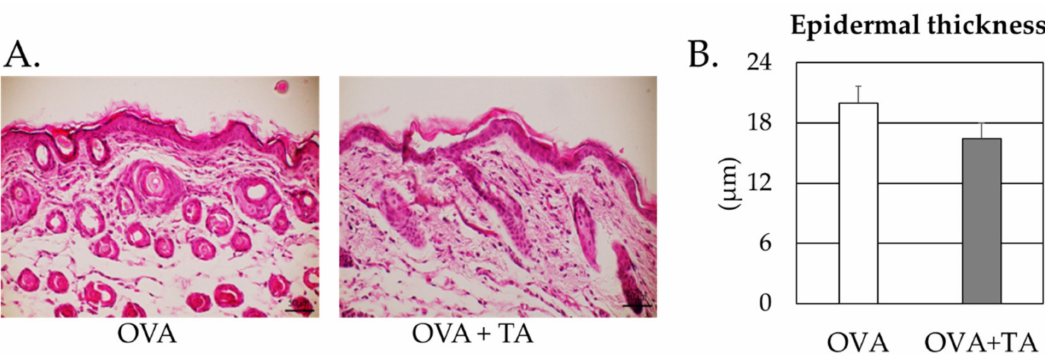
Figure 7. H&E stain results for the skin sections from OVA and OVA + TA groups. ( A ) H & E stain. The scale bars indicate 50 µ m. ( B ) epidermal